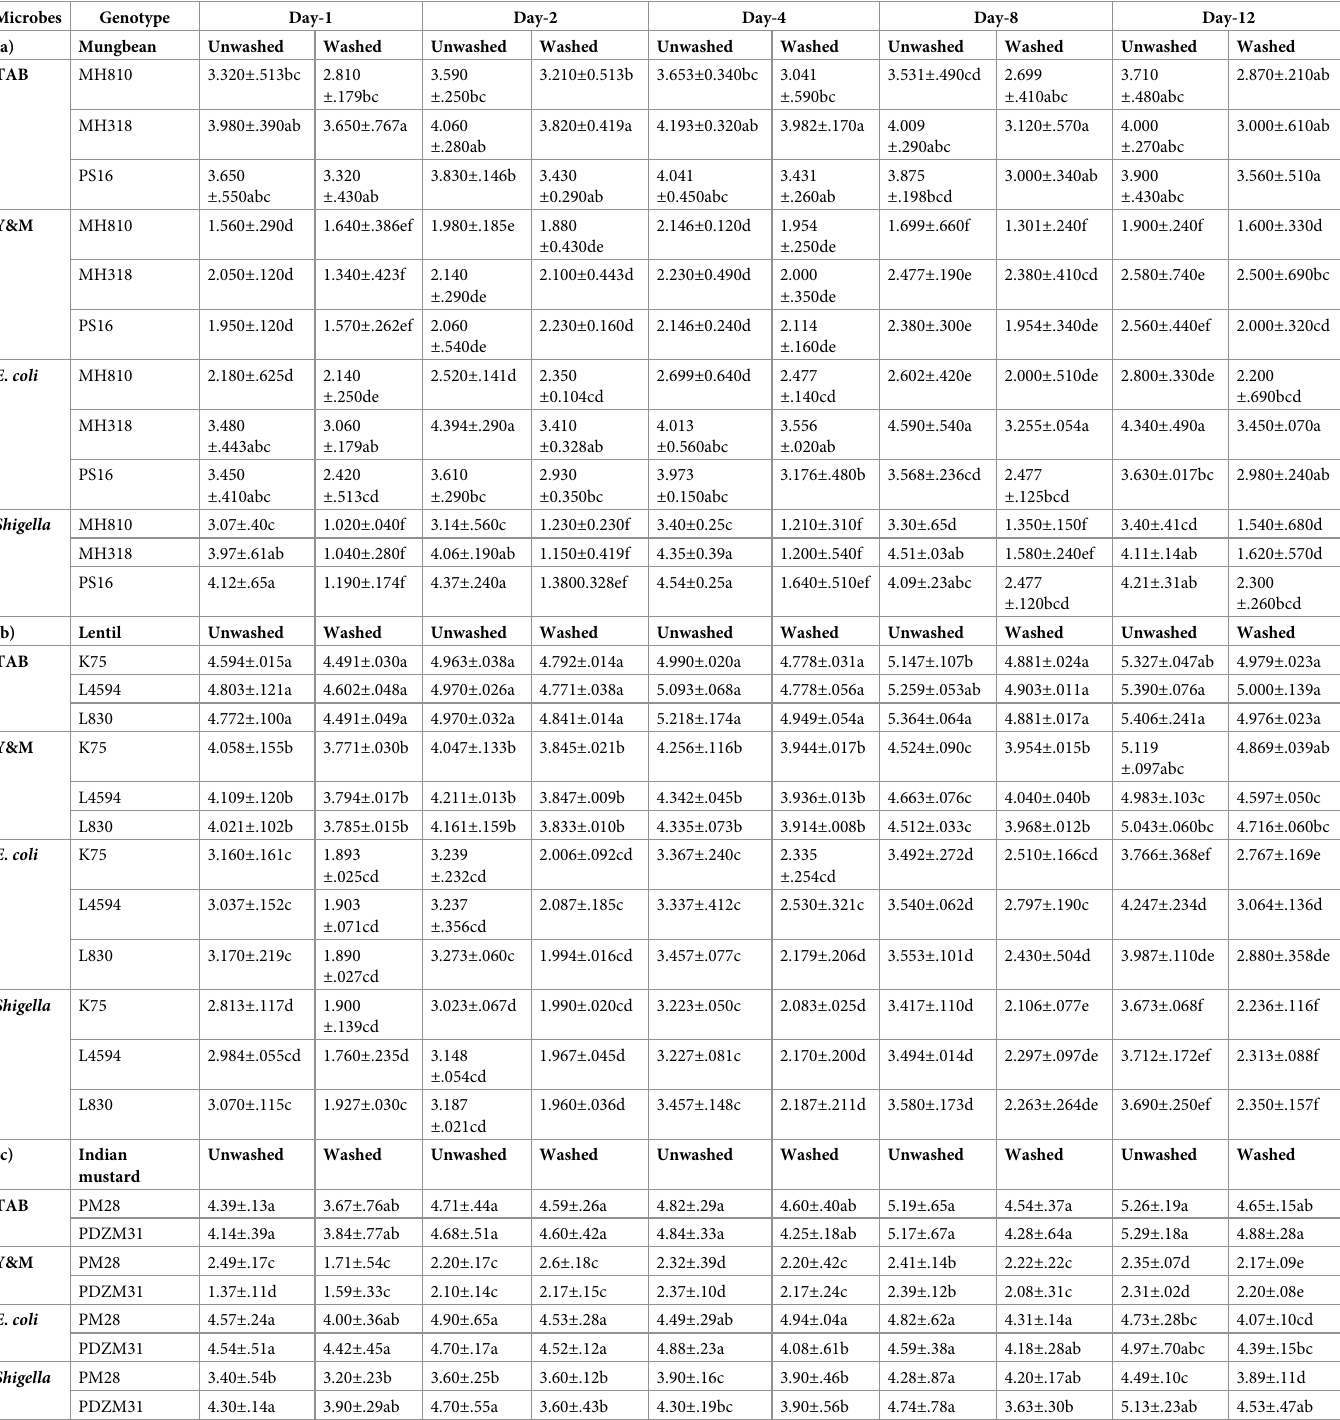
Table 4. Microbial load in three genotypes each of lentil (K75, L4594 & L830) and mungbean (MH810, MH318 & PS16) and two genotypes of Indian mustard (PM28, PDZM-31) microgreens after 1 st , 2 nd , 4 th , 8 th , and 12 th day of storage at 4˚C under washed and unwashed conditions. Microbes